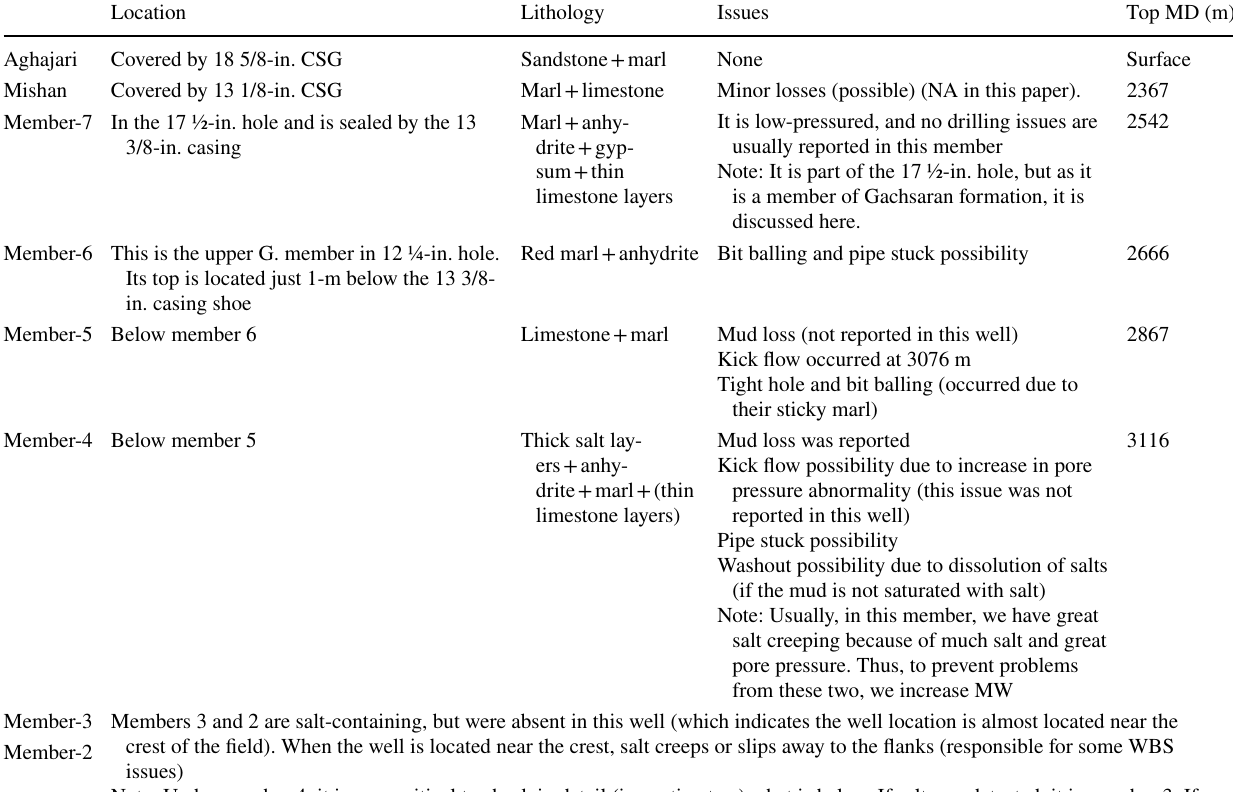
Table 5 The results of graphical well log (obtained from geologist’s cuttings analysis) of well Z26 (from top to bottom). It includes Gachsaran formation including its seven member/layers